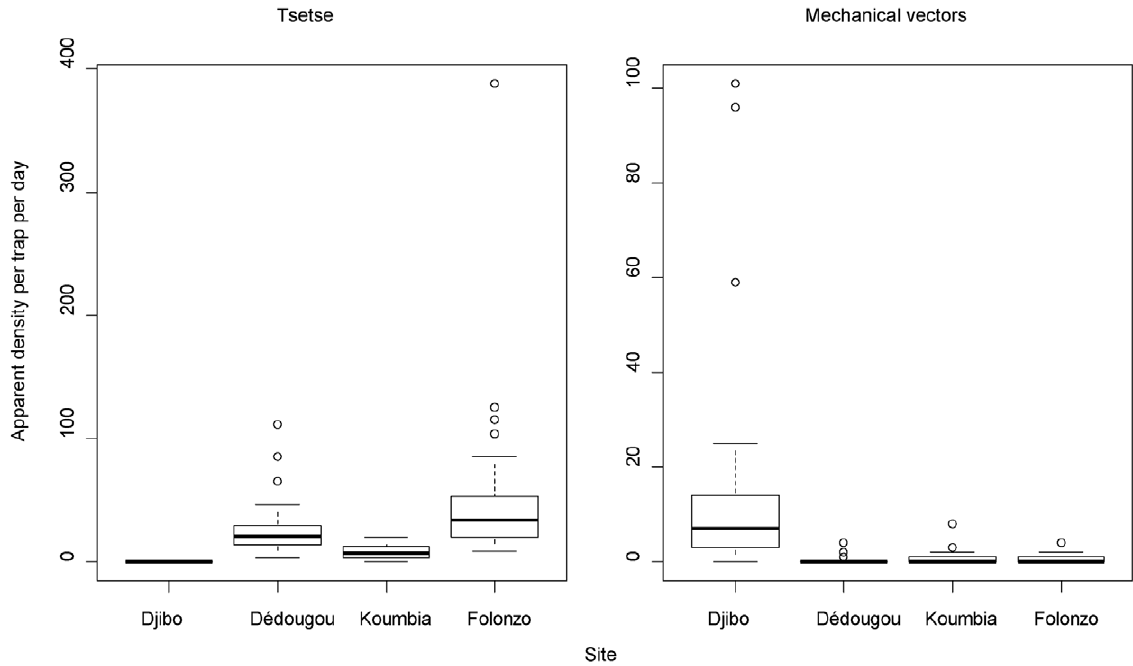
Figure 2. Distribution of biting flies along the climatic gradient in Burkina Faso. Sites are ordered by increasing annual rainfall from the left to the right. Boxplots present the median (bold line), quartiles (boxes), 95% confidence intervals (horizontal lines) and erratic values (dots). doi:10.1371/journal.pone.0049762.g002 PLOS ONE |